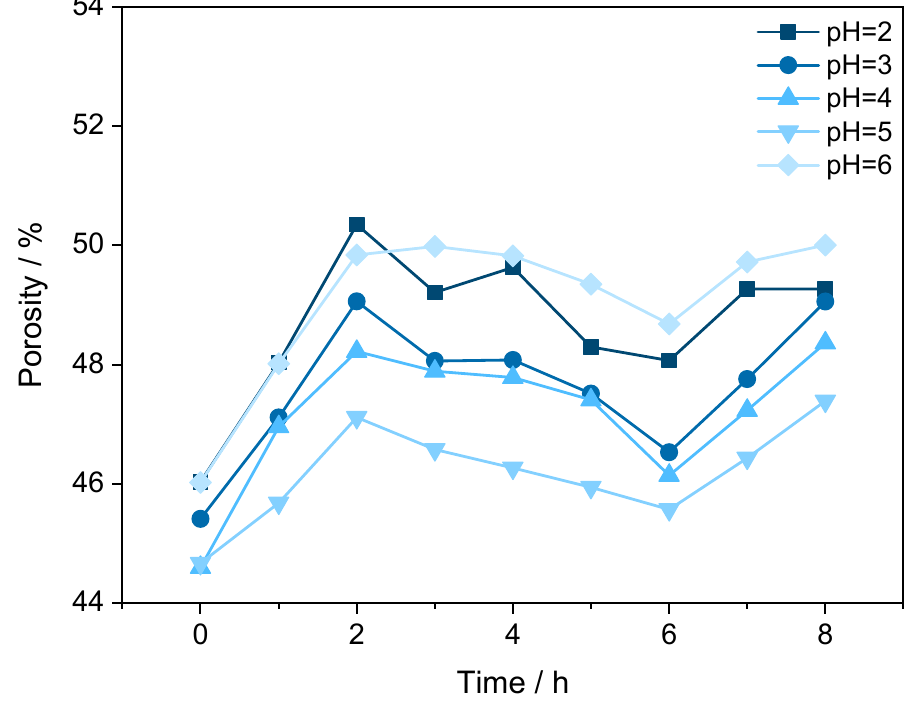
Figure 10. Curve of porosity of samples with pH of different leaching agents.